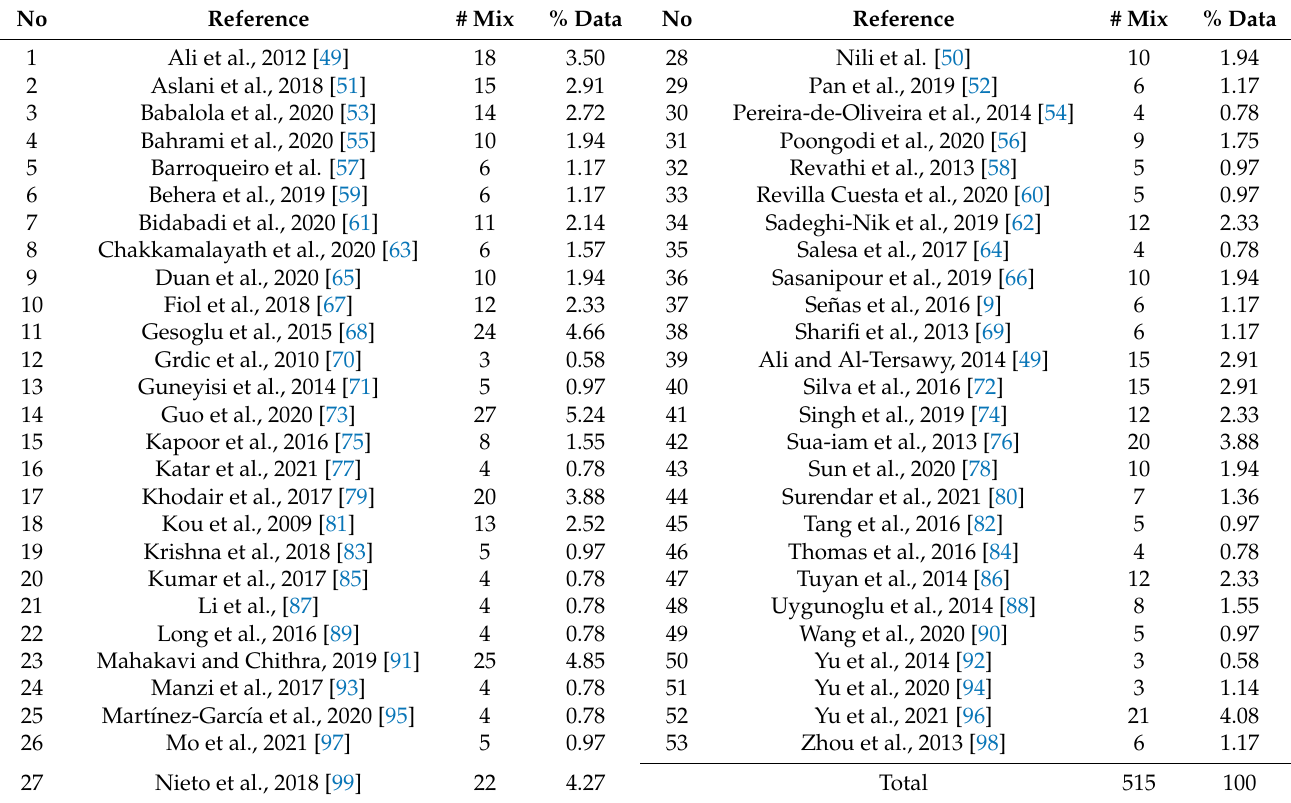
Table 1. Experimental